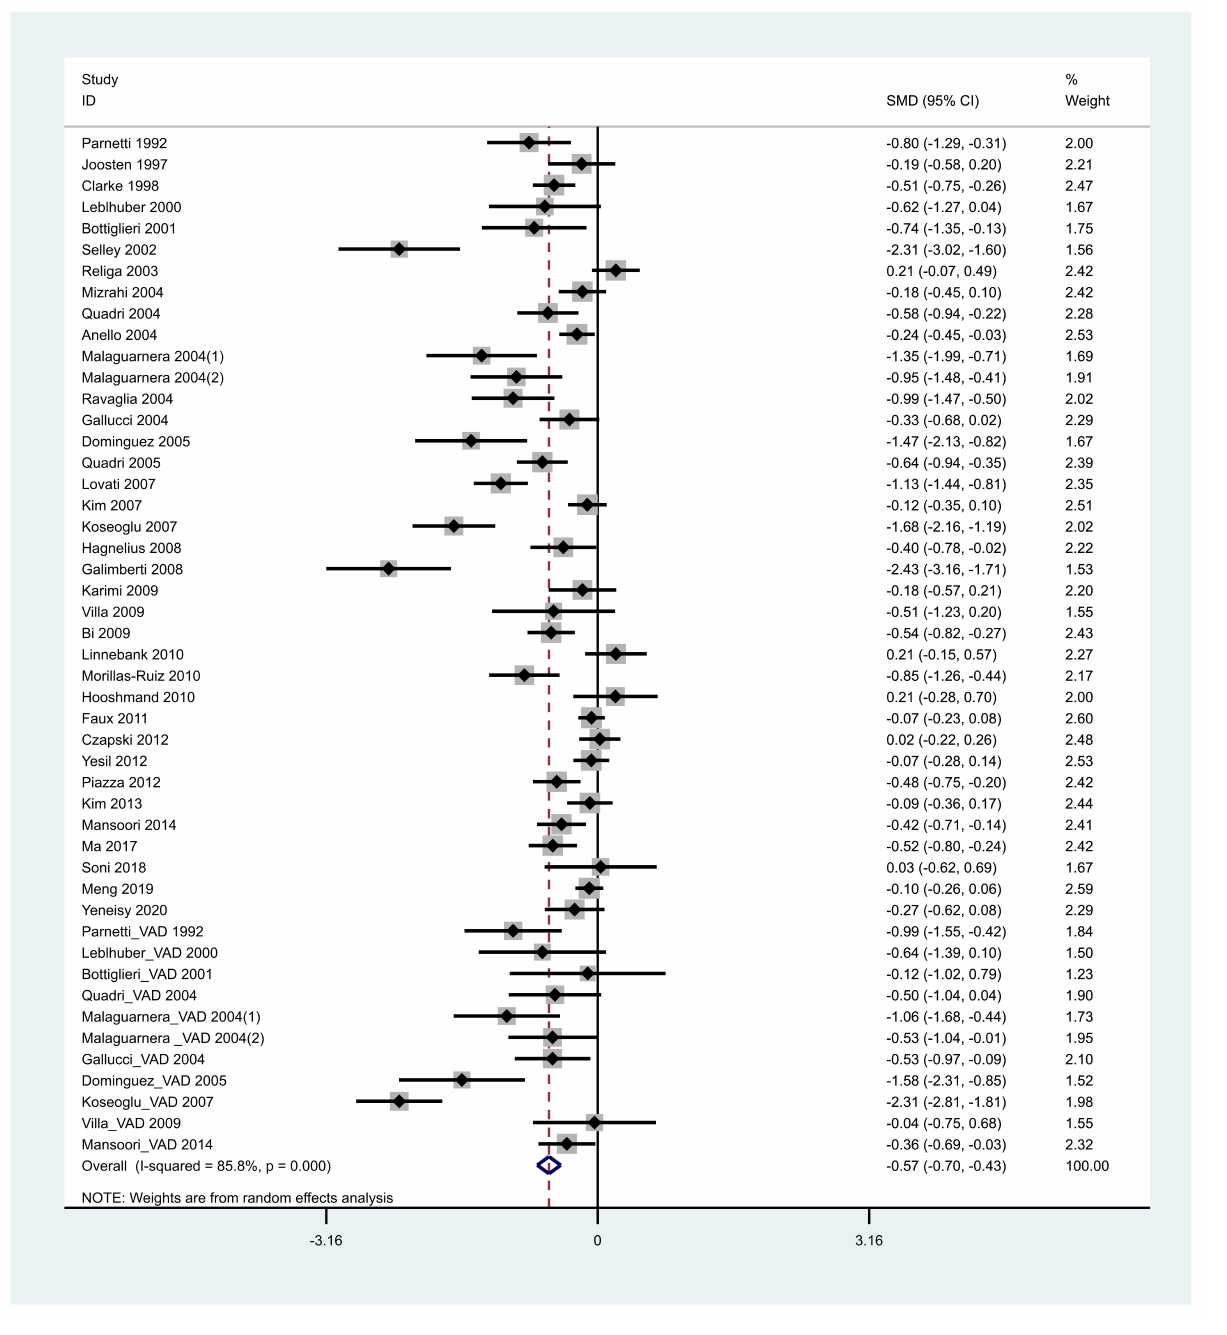
model was used to take additional account of study